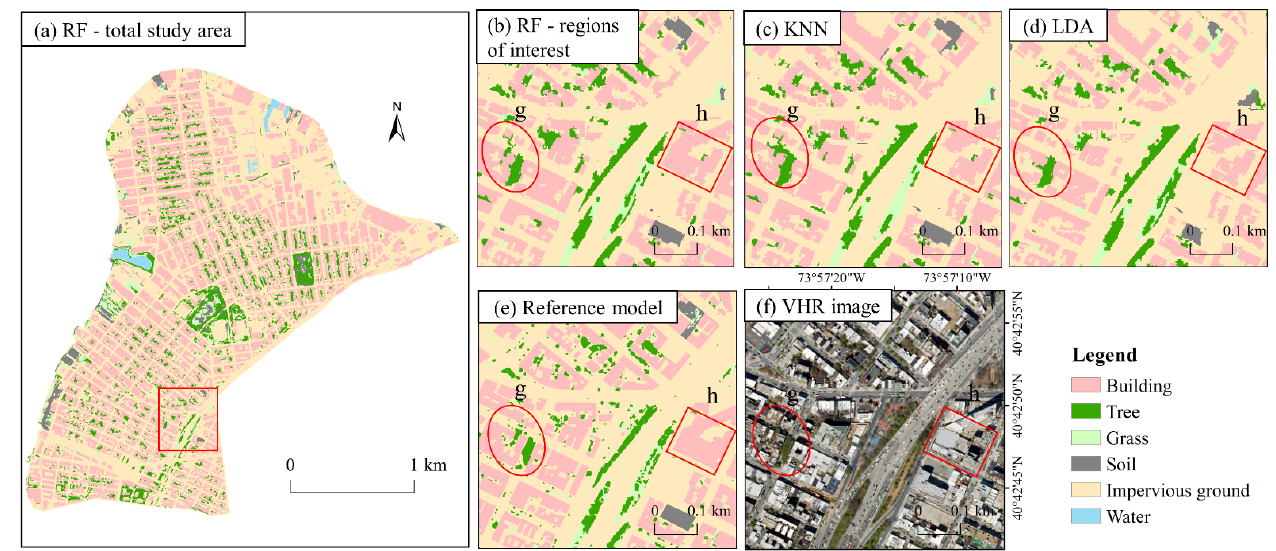
Figure 6. Comparison of classification details by using the three classifiers. ( a ) RF classifier—total study area, ( b ) RF classifier—regions of interest, ( c ) KNN classifier, ( d ) LDA classifier, ( e ) reference model and ( f ) VHR image.